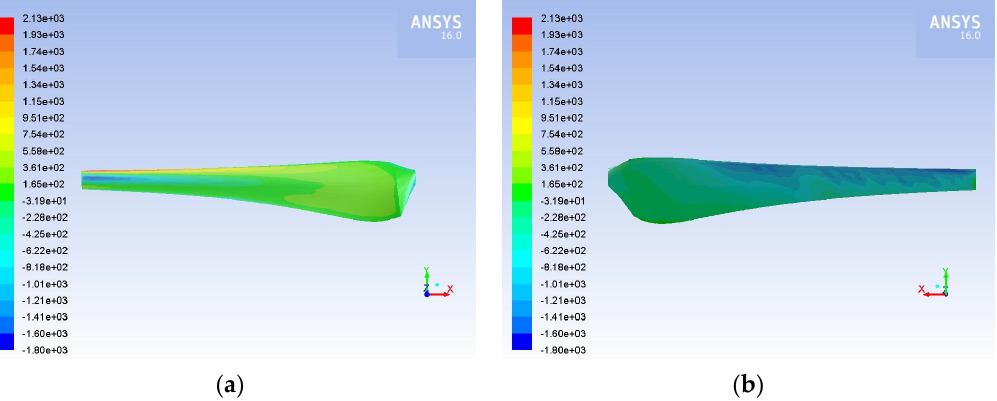
Figure 11. Contours of pressure on ( a ) the pressure; ( b ) the suction side of the blade for hailstorm conditions and air velocity equal to 10 m·s − 1 .